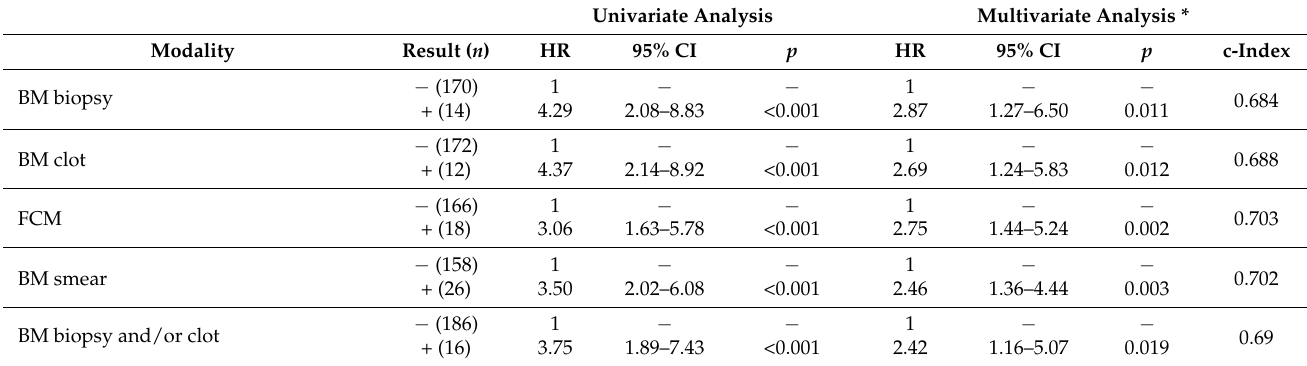
Table 4. Impact of the detection of BM involvement by single or combinatory modality on progression-free